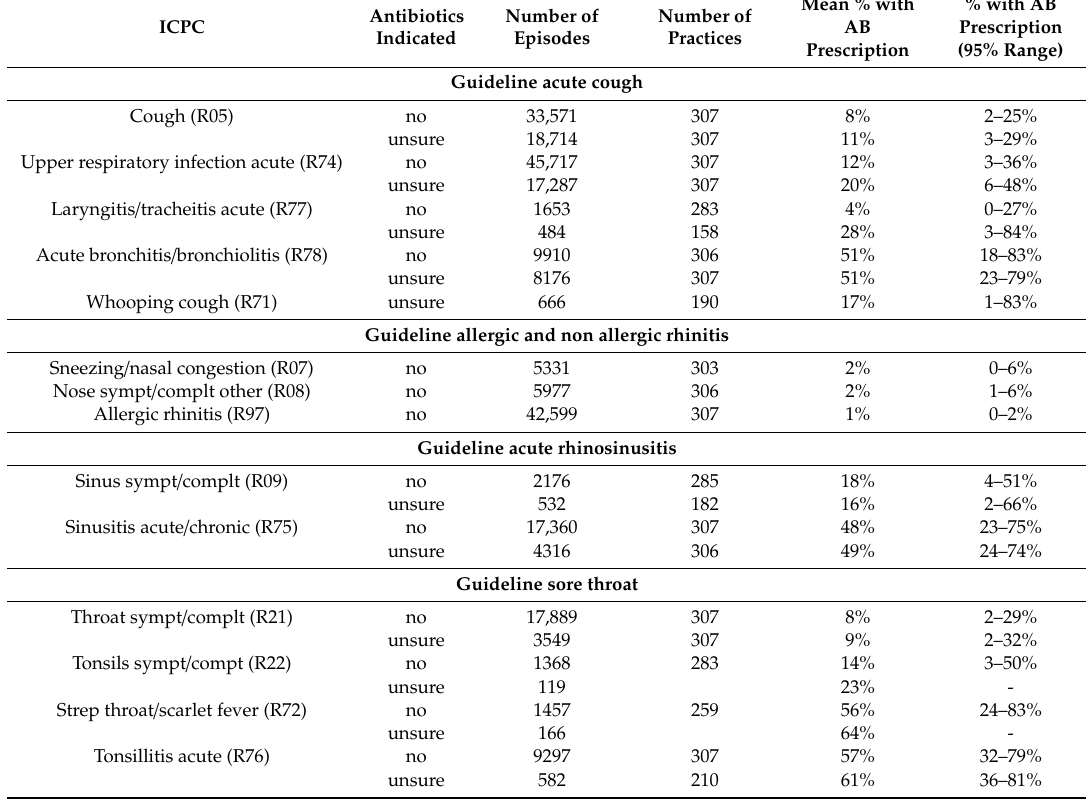
Table 2. Practice variation in antibiotic prescribing for respiratory tract infections (RTIs) with unsure and without antibiotic